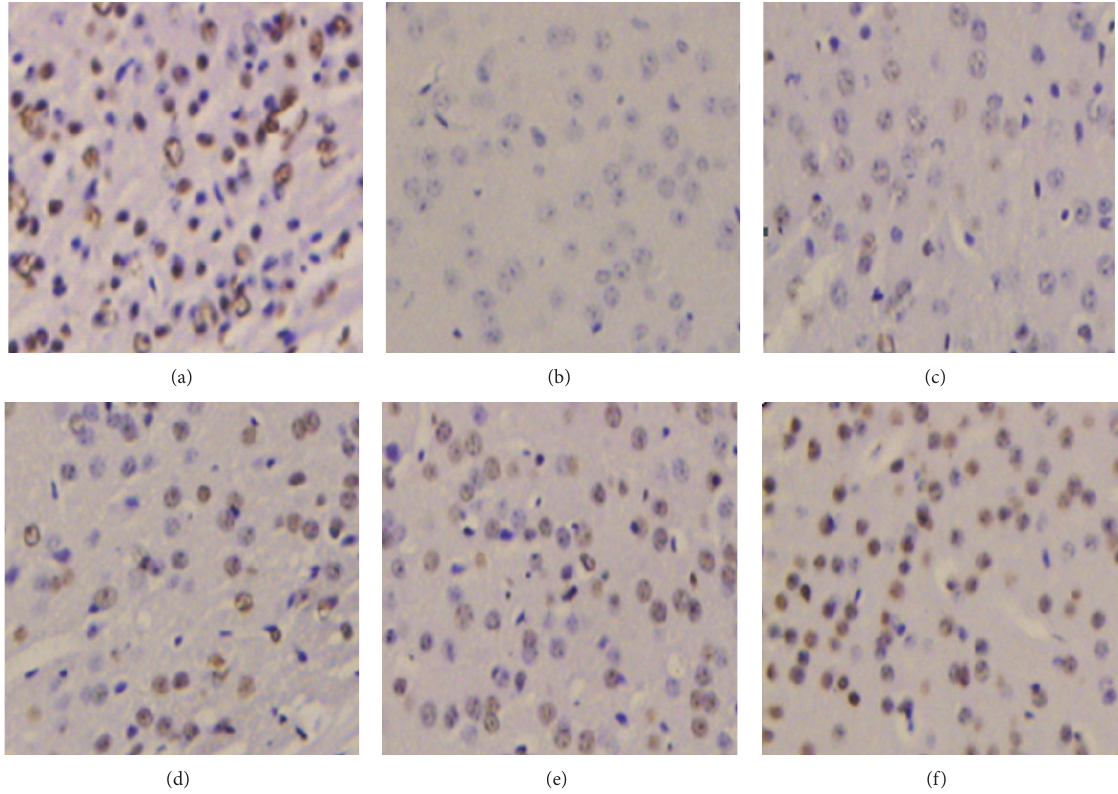
Figure5:Effectof Chorisporabungeana waterextractoncellapoptosisinmicesubjectedtocerebralischemia/reperfusion.Nucleushasbrown granules were positive cell. (a) Model group; (b) sham group; (c) Edaravone-treatment group (3mg/kg); (d) Chorispora bungeana -treatment group (5 g/kg); (e) Chorispora bungeana -treatment group (2.5 g/kg); (f) Chorispora bungeana -treatment group